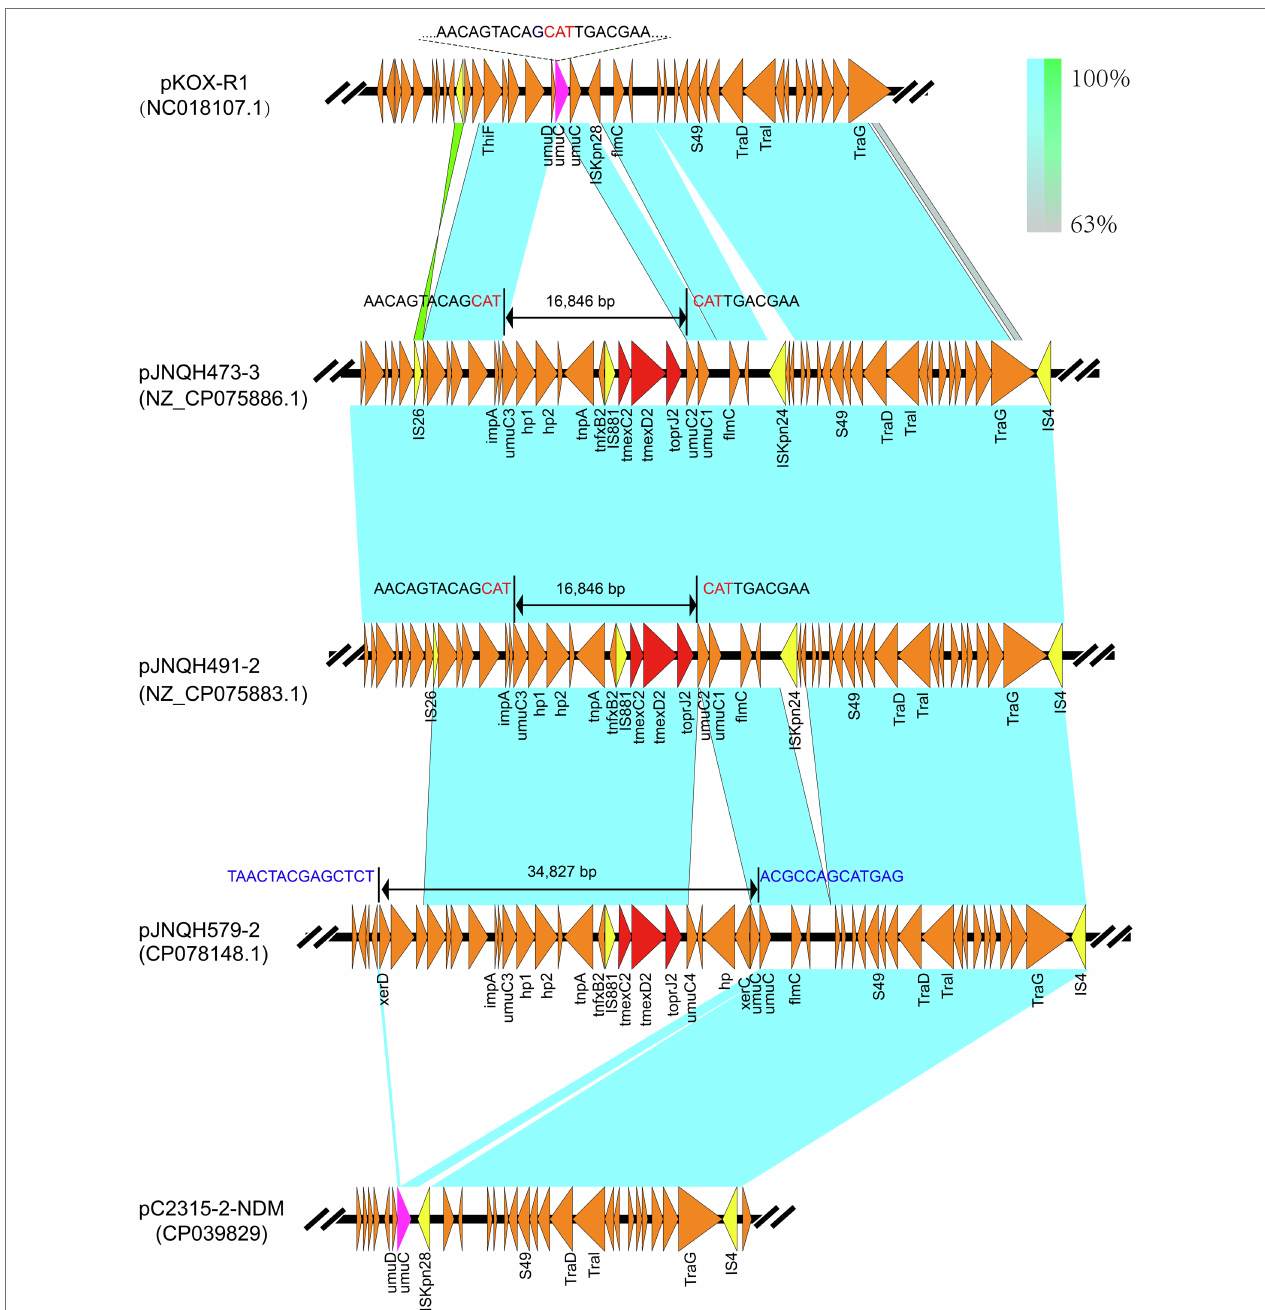
FIGURE 2 | Linear comparisons of TmexCD2-ToprJ2 -bearing genetic contexts in pJNQH473-3 and that in pJNQH579-2, pC2315-2-NDM, and plasmid pKOX_ R1(NC018107.1). Light blue shading indicates shared regions of homology, while green shading indicates inversely displayed regions of homology. Colored arrows indicate ORFs. The red arrows indicate the antibiotic resistance genes. The yellow arrows indicate IS. The nucleotide sequence of the umuC gene (green arrow) representing the insertion site is shown above the gene. The 16,846 bp putative “ hp1-hp2-tnpA-tnfxB2-IS881-TmexCD2-ToprJ2 ” transposon located on pJNQH473-3 and 34,827 bp larger putative transposon on pJNQH579-2 are marked with bilateral black